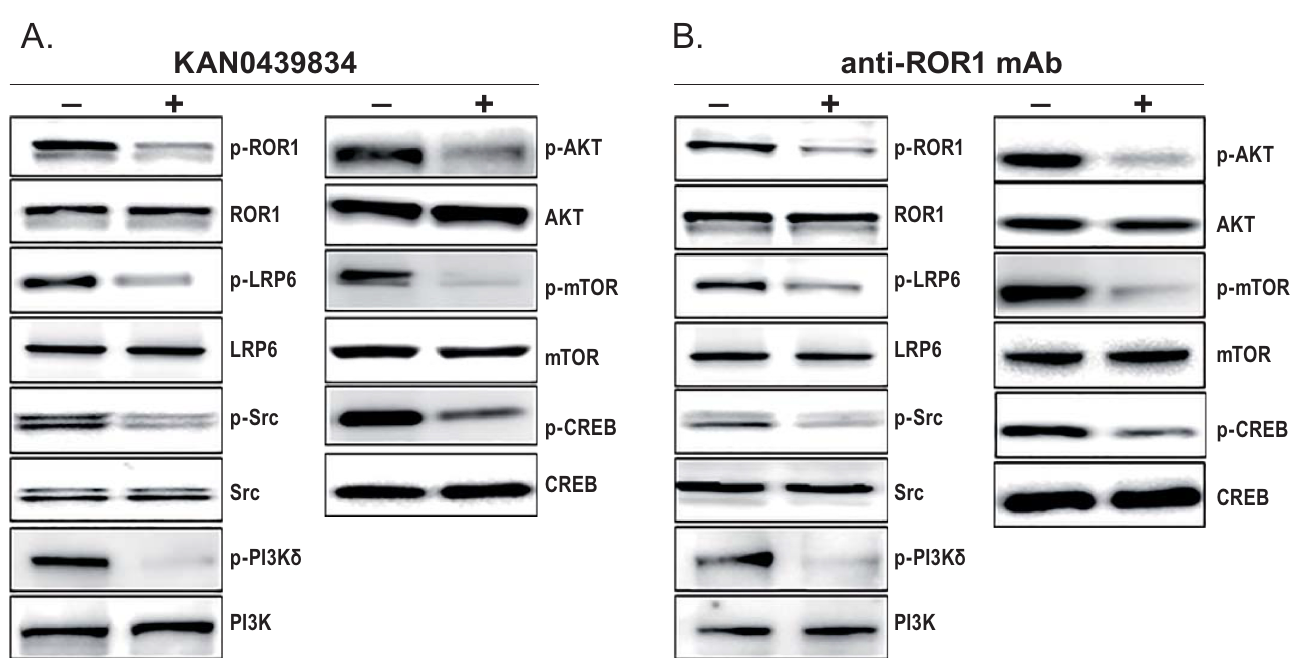
Fig 8. Effects of KAN0439834 and anti-ROR1 mAb on ROR1 associated signaling molecules in the pancreatic cancer cell line PaCa-2. Western blots showed inhibition of ROR1, LRP6, SRC, PI3K δ , AKT, mTOR and CREB phosphorylation after incubation (2 h) with (A) KAN0439834 (500 nM) and (B) anti-ROR1 mAb (10 μ g/ml). (+) treated cells and (-) untreated cells.